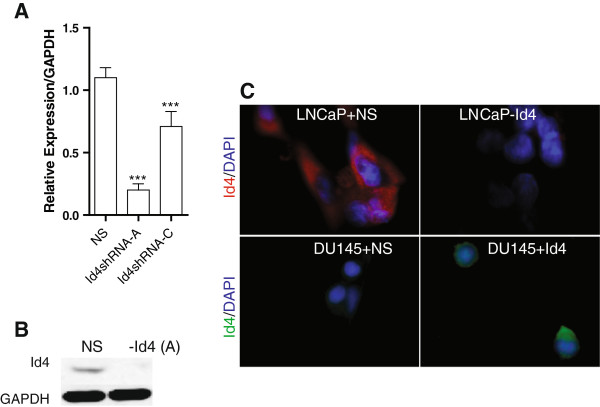
Stable knockdown of Id4 by retroviral shRNA in LNCaP cells (retroviral vectors A and C) and stable over-expression of hId4 in Du145 cells. A. Real time quantitative polymerase chain reaction for Id4 expression in LNCaP (NS, non-specific) following transfection with Id4 shRNA vectors A and C and non-silencing shRNA (NS) (***: P < 0.001). B. Western blot analysis of Id4 expression in LNCaP cells with non-specific shRNA (NS) and Id4 specific shRNA (-Id4, vector A). C: Immuno-cytochemical analysis of stable knockdown of Id4 expression in LNCaP cells (LNCaP-Id4, vector A) as compared to cells with non-specific shRNA (LNCaP + NS). The red staining indicates Id4 expression (DyLight 594). Id4 expression in DU145 cells stably transfected with Id4 expression vector (DU145 + Id4) as compared to DU145 cells transfected with empty vector (DU145 + NS). The green staining represents Id4 (DyLight 488). DAPI was used to stain the nuclei (blue) in both LNCaP and DU145 cells. Representative images are shown.